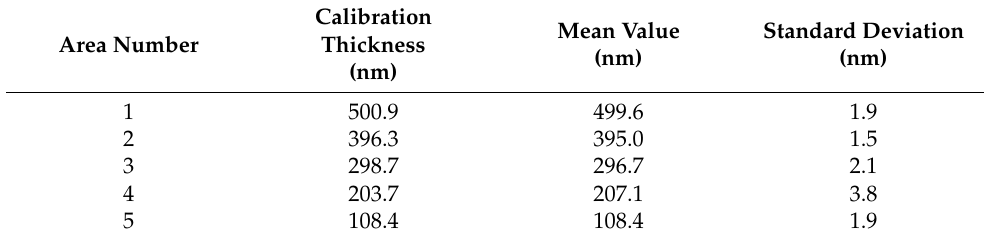
Table 3. Measurement results for the stepped samples.